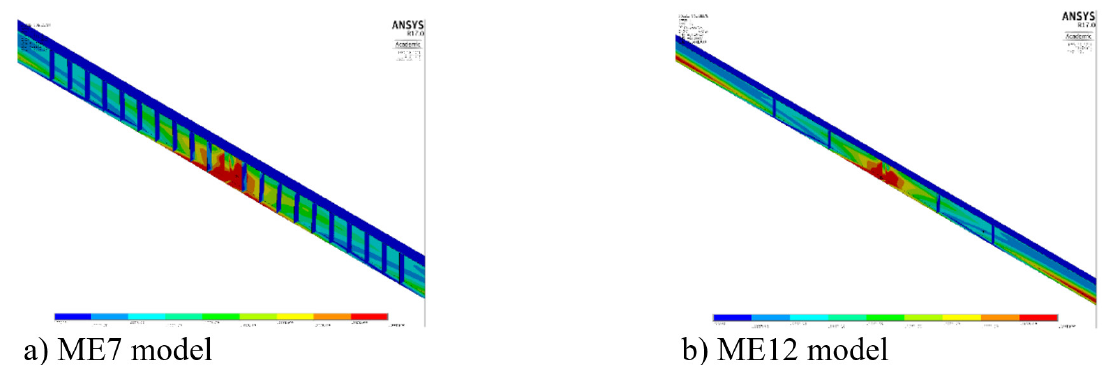
Figure 11. Von Mises stress in the steel profile of models ME7 and